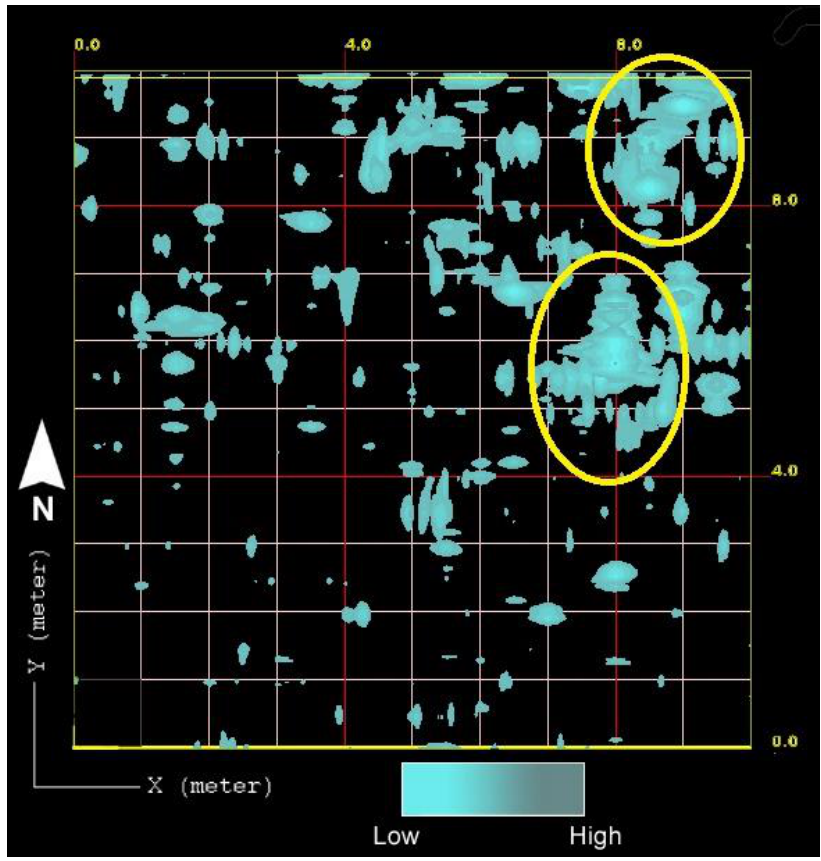
Figure 10. Time slice at a depth of 0.75 m for GPR3 area (parking lot), SIR-3000 device. Profiles made every 0.5 m on the X and Y axes. Yellow color marks irregular anomalies.